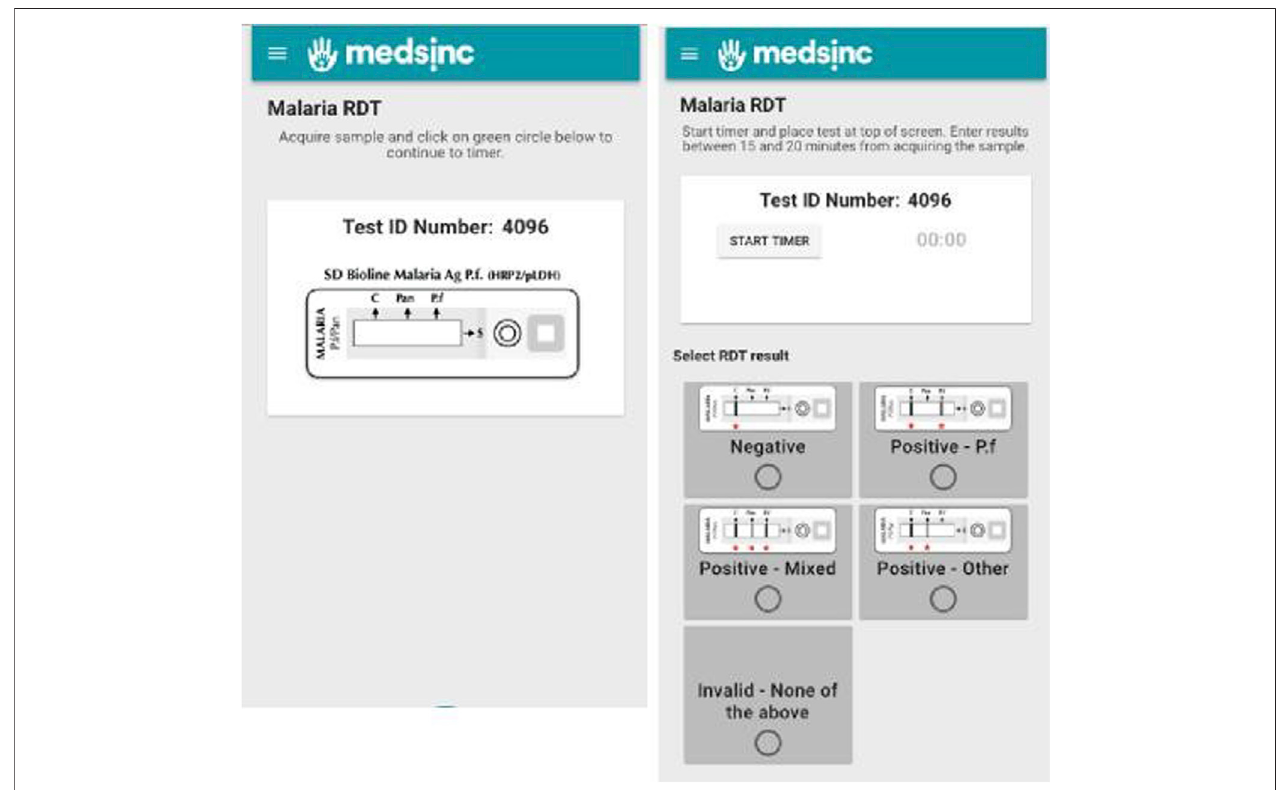
FIGURE 2 | Embedded mRDT work fl ow panels for acquiring and reporting mRDT results by